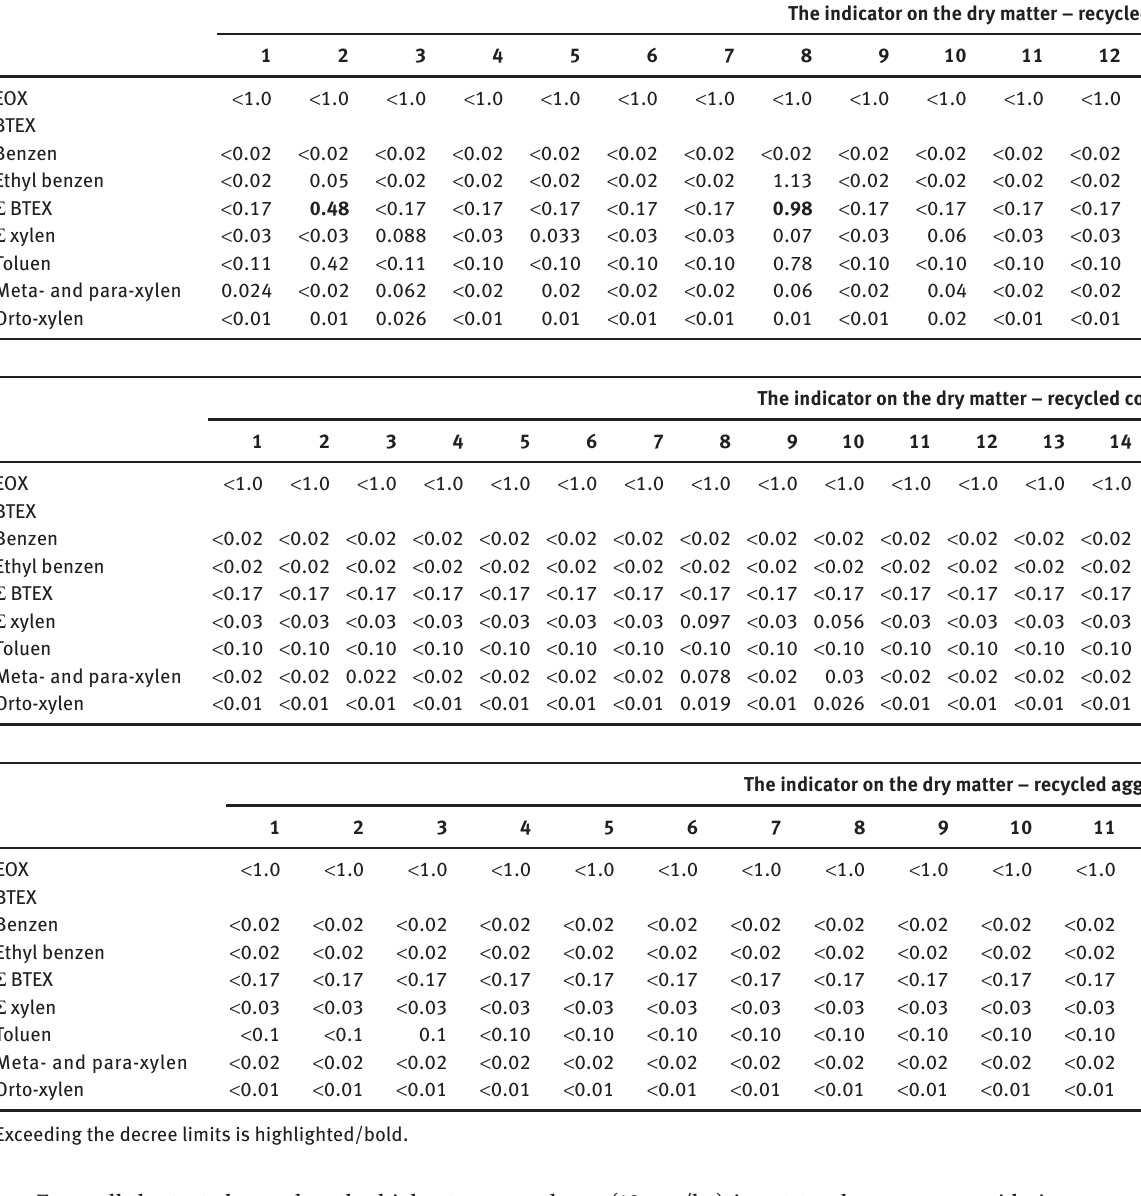
Table 5: Contents of hazardous substances.